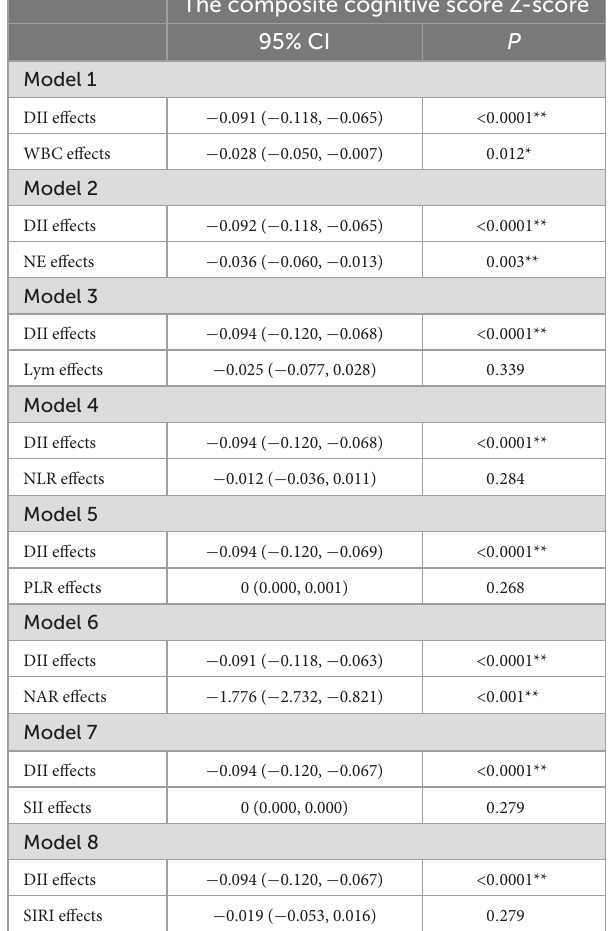
TABLE 3 Relationship between DII and cognitive function after binding TABLE 4 Relationship between DII and each blood inflammatory index in of each blood inflammatory index separately. a cognitively impaired population. The composite cognitive score Z-score The composite cognitive score 95% CI